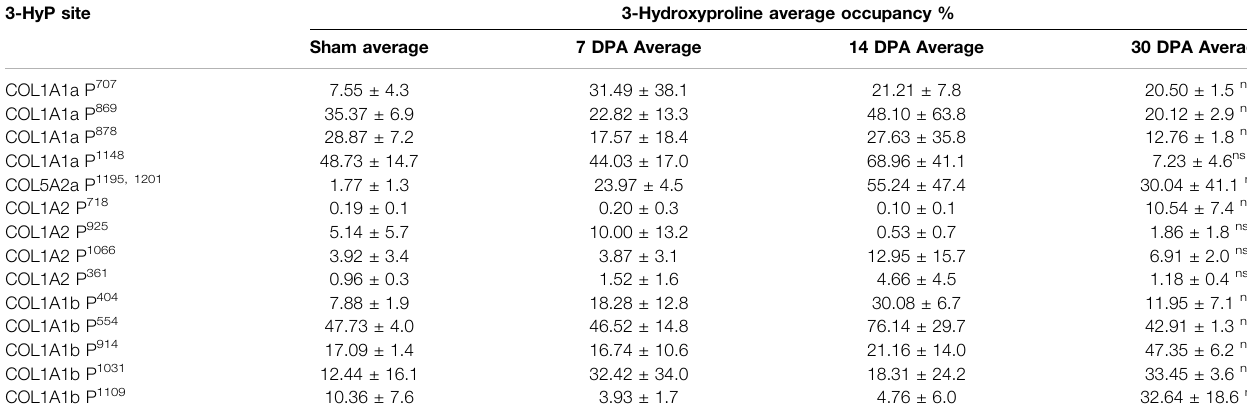
TABLE 2 | Quantitative occupancy (%) of 3-hydroxyproline (3-HyP) sites identi fi ed in three different chains of collagen I (COL1A1a, COL1A1b, and COL1A2) from zebra fi sh cardiac ECM. Results are expressed as mean ± S.D. Signi fi cant statistical differences were estimated by ANOVA (* p < 0.05, ns p > 0.05).